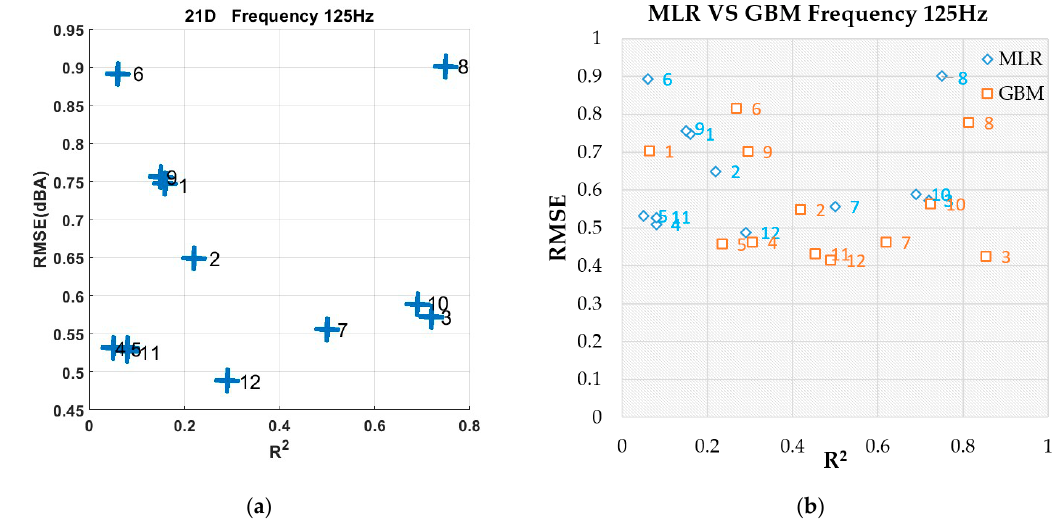
Figure 14. ( a ) Performance of multiple linear regression (MLR) method. ( b ) Combine MLR and gradient boosting model (GBM).